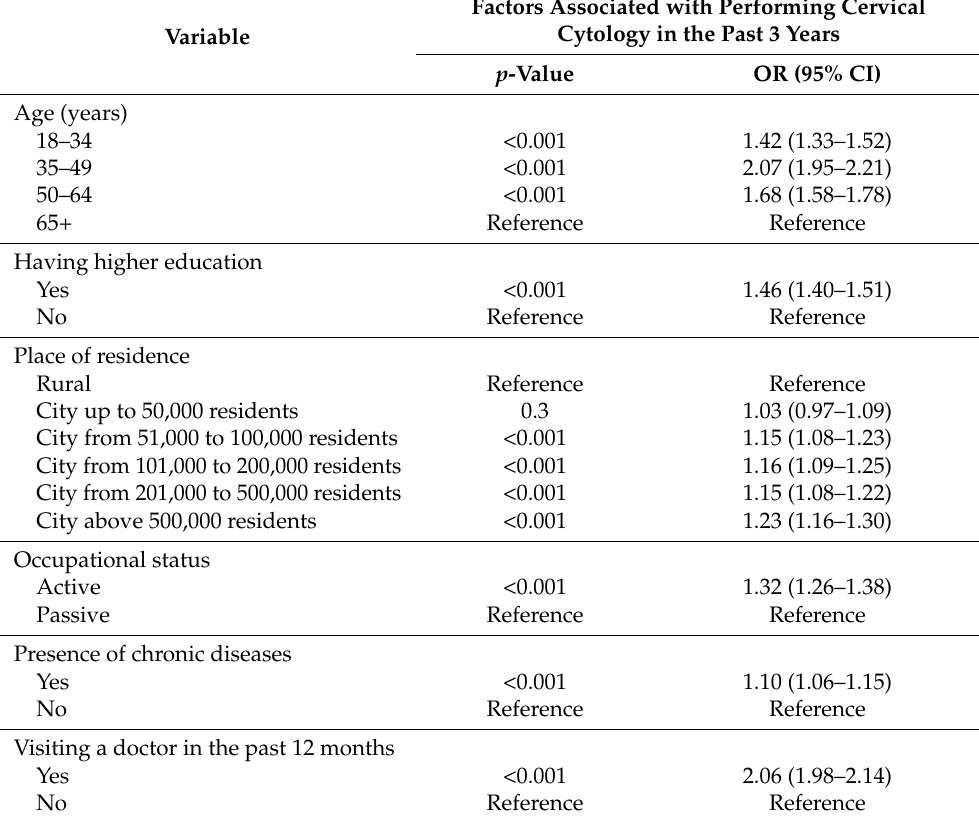
Table 6. Factors associated with cervical cytology testing in the past 3 years among adult females in Poland ( n = 58,904)—multivariable logistic regression